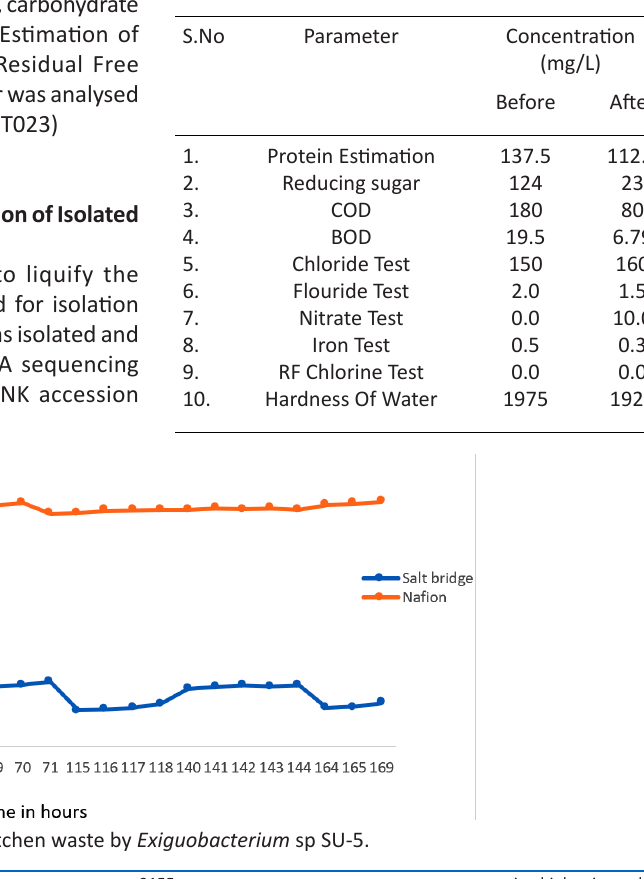
Table 1. Analysis of kitchen waste treatment in MFC